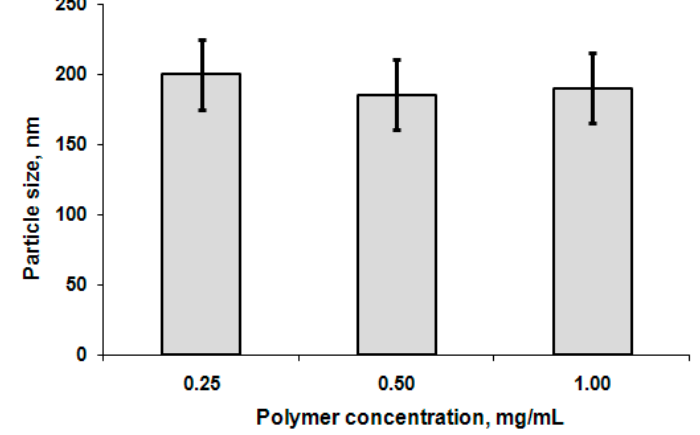
Figure 4. Dependence of particle size on polymer concentration (polymer sample GP3, pH 8.4).